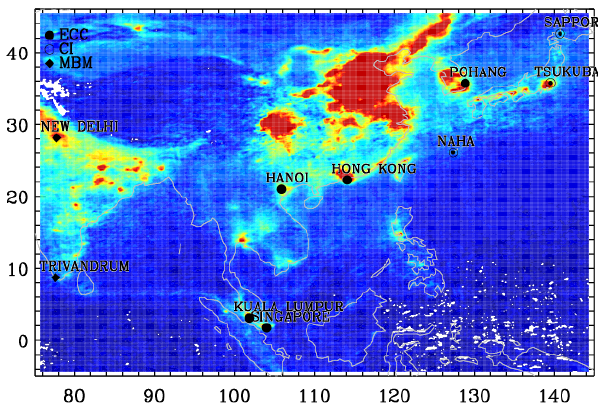
Figure 2. Geographic locations of the ozonesonde stations available since 2005 over the GEMS observation domain. Each symbol rep- resents a different type sensor: the modified Brewer–Mast (MBM), the carbon–iodine cell (CI), and the electrochemical concentration cell (ECC). The background map illustrates the OMI NO 2 monthly mean in June